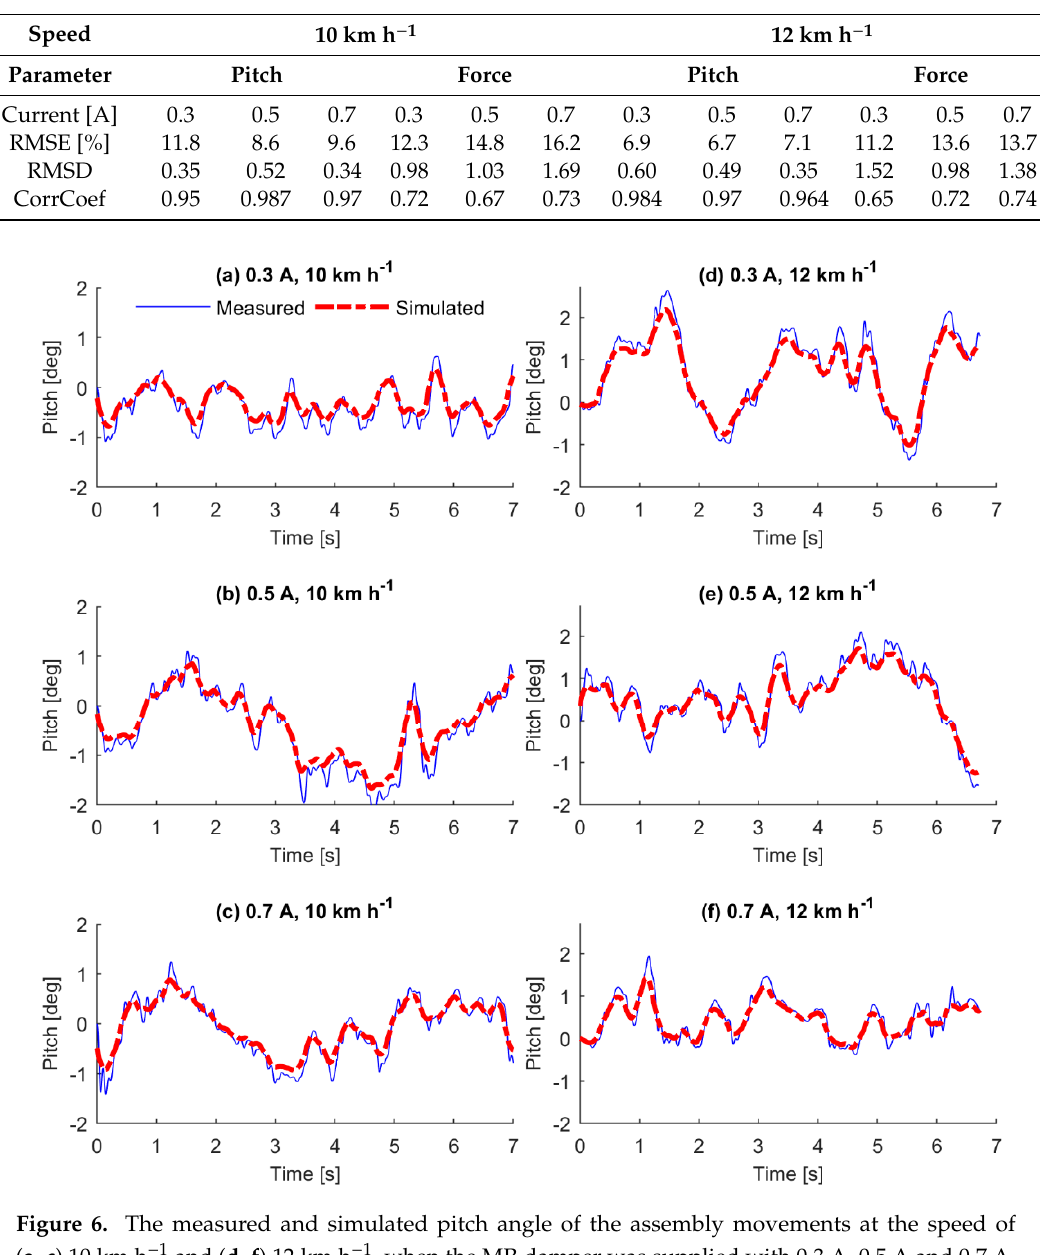
Table 1. Root-mean-squared-error (RMSE) in percentage, root-mean-squared-deviation (RMSD) and correlation coe ffi cient.